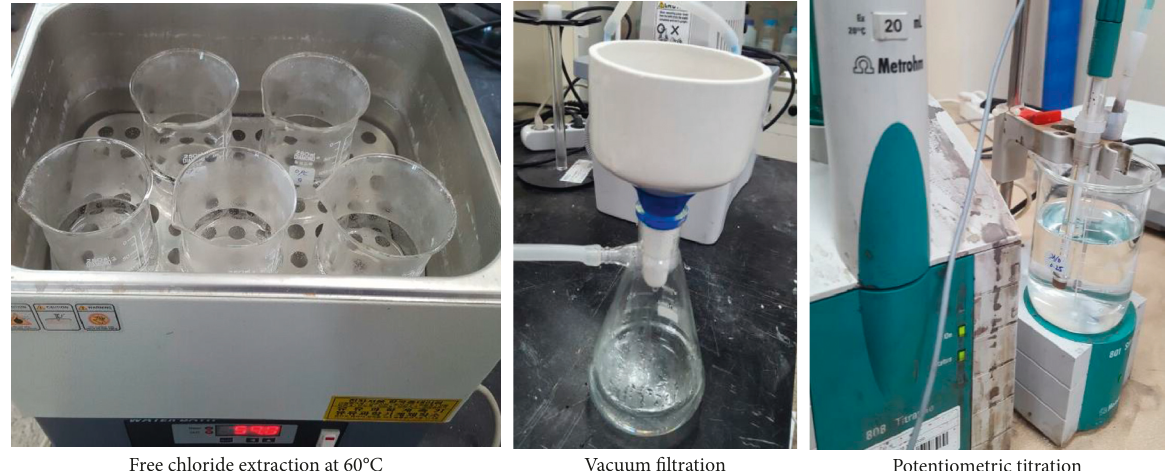
Figure 3: Water-soluble chloride extraction and